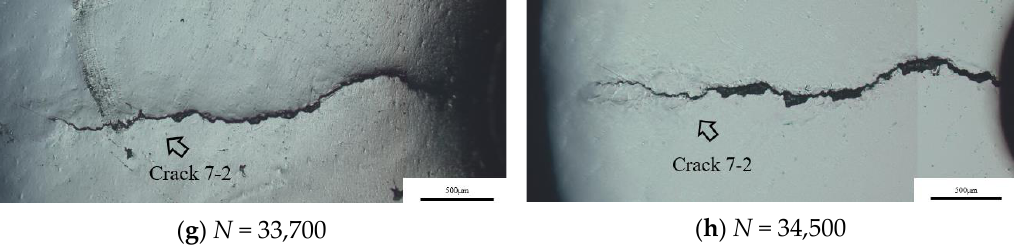
Figure 13. Crack 7-2 initiation and propagation process.